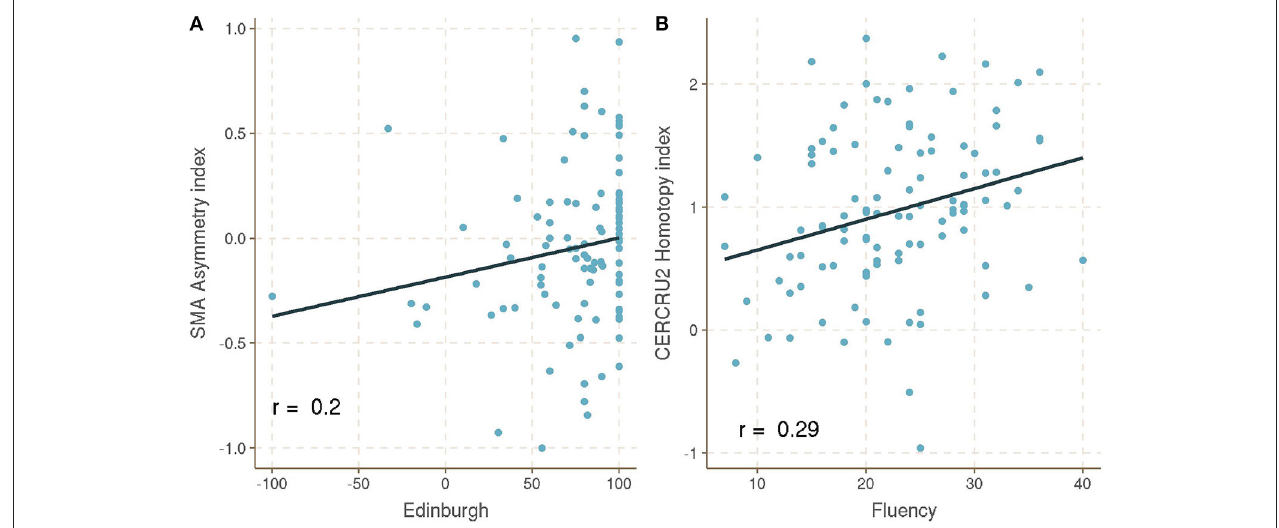
FIGURE 2 | (A) Asymmetry index and (B) homotopy functional connectivity between Verbal Fluency Test and EHI with significant brain regions, false discovery rate (FDR) corrected, calculated using Spearman’s rank correlation. SMA, supplementary motor area; CERCRU2, crus II of cerebellar